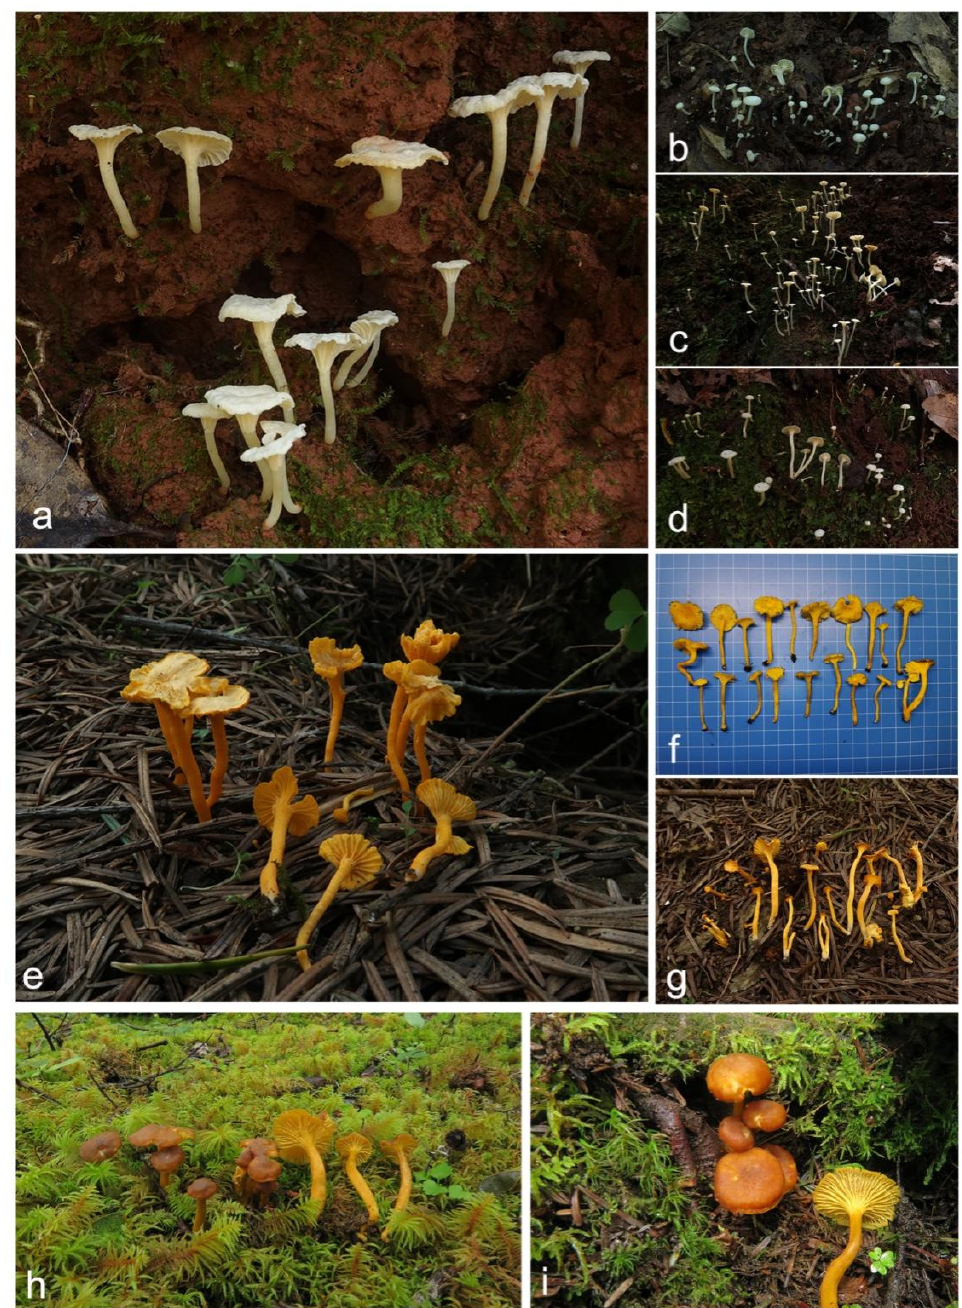
Figure 11. Species of Cantharellus subg. Parvocantharellus from China. ( a – d ) C. minioalbus ( a ) GDGM78926; ( b ) GDGM78901 holotype! ( c ) GDGM78934; ( d ) GDGM78910; ( e – g ) C. sinominor ( e ) GDGM80842 holotype ( f ) GDGM80788; ( g ) GDGM80885; ( h – i ) C. zangii ( h ) GDGM83181; ( i ) GDGM83193.